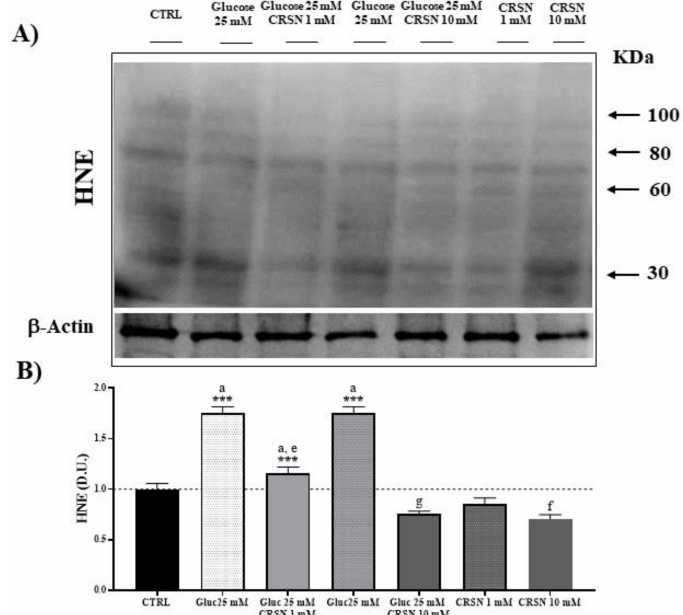
Figure 6. Glucose stress (25 mM) increased HNE (4-hydroxy- trans -2-nonenal) protein concentration in murine podocyte cells compared to controls by 75%. Incubation with carnosine (1 mM and 10 mM) significantly reduced HNE protein concentration ( p = 0.007 and p = 3.1 × 10 − 3 ). Co-incubation with carnosine (1 mM and 10 mM) and glucose (25 mM) reduced HNE protein concentration vs. glucose alone ( p = 1.1 × 10 − 6 and 1.9 × 10 − 9, respectively), determined by western blotting ( A ) and quantified with an imaging software normalized to respective β -actin concentrations ( B ). Note: n = 5, a = increased vs. control, e = decreased vs. glucose (25 mM), f = decreased vs. carnosine (1 mM), g = decreased vs. glucose (25 mM) + carnosine (1 mM), *** p < 0.001 vs.